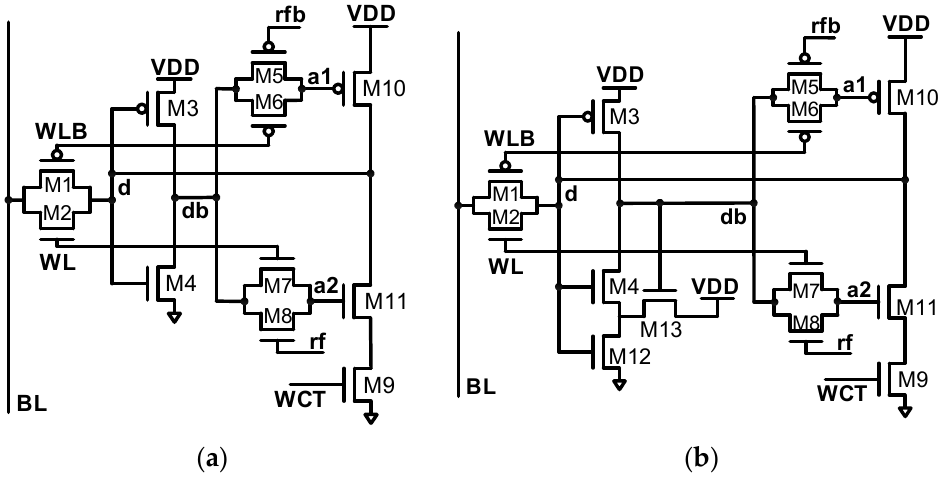
Figure 7. Schematic of ( a ) QUCCE-10 T and ( b ) QUCCE-12 T SRAM cell. However, the full positive feedback of QUCCE-10 T considerably lowers the SEU tolerance compared to the other radiation-hardened SRAM cell designs. An SEU-induced voltage change at any storage node can trigger the positive feedback, which in turn makes the initial voltage change severe. For example, for the data “1” stored cell—A = 0 V, B = V DD , Q = V DD , and QN = 0 V—0 to 1 SEU can occur on the QN node, leading to the pull- down of the Q node. This turns on P1 to raise the node A, so N4 is turned on, leading to the pull-down of B. As a result, P3 is turned on, making the voltage rise of QN more se- vere. In addition, QUCCE-10 T suffers from a large write delay or reduced write stability in low-voltage regions. For example, when “0” is written to the “1” stored cell, Q = V DD is supposed to be pulled down by the turned-on N5. For a successful write, WL should be kept high until Q is lowered, A is raised, and then B is lowered so that QN becomes V DD to ensure that N2 is fully turned on. This necessitates a large pulse width for WL assertion, which results in an excessive write delay. To resolve this problem, QUCCE-12 T, shown in Figure 7b is also proposed, but the limited SEU tolerance issue still exists in QUCCE-12 T. Figure 8a,b show the schematics of RHBD-11 T [12] and the 13 T SRAM cell [20], respectively. The key structural feature of these designs is that the nodes a1 and a2 are isolated and the refresh signals—rf and rfb—are employed. The roles of these refresh signals are to be explained later. There are four nodes to store the data; the nodes d, db, a1, and a2.